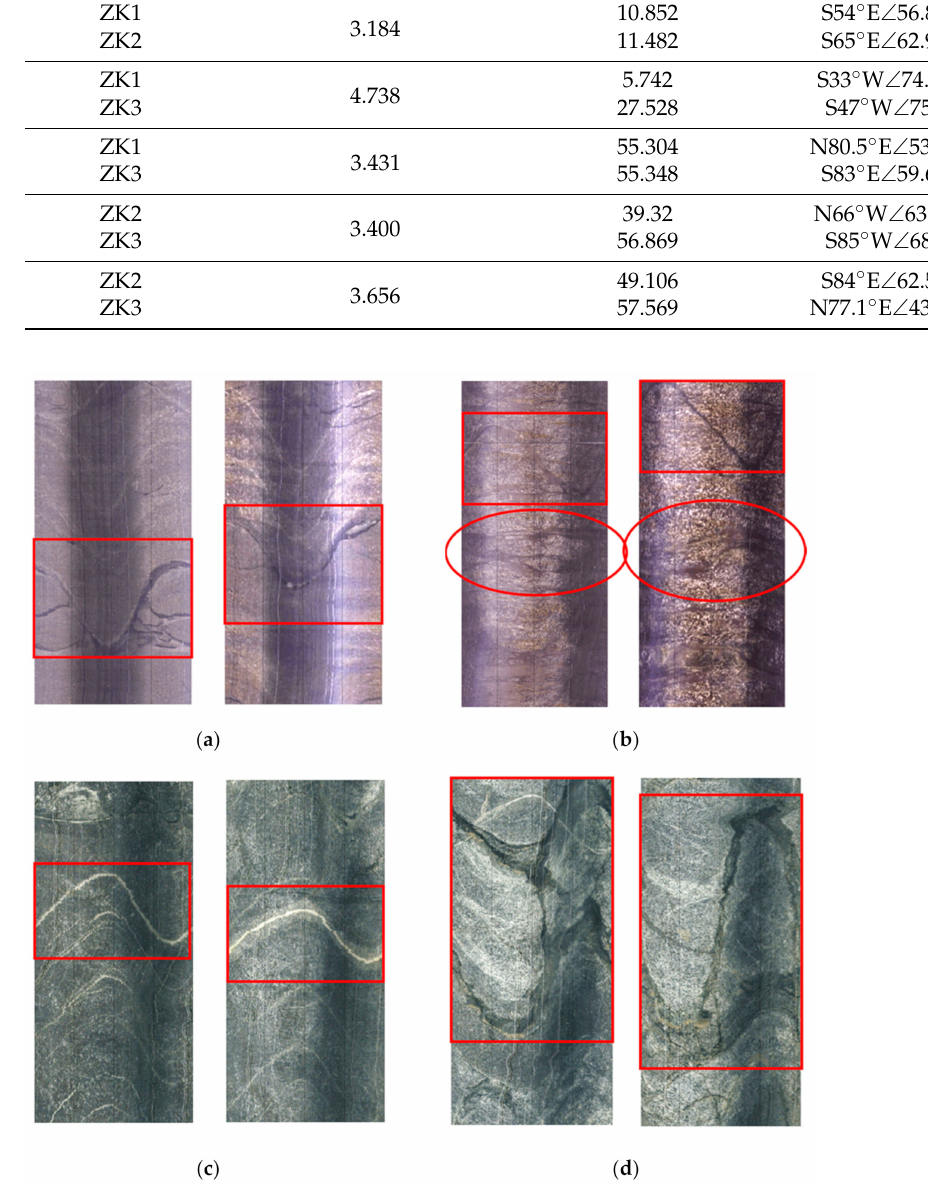
Figure 16. Four sets of possible coherent structural planes, ( a – d ) correspond to 1, 3, 5 and 6 groups of data in Table 5